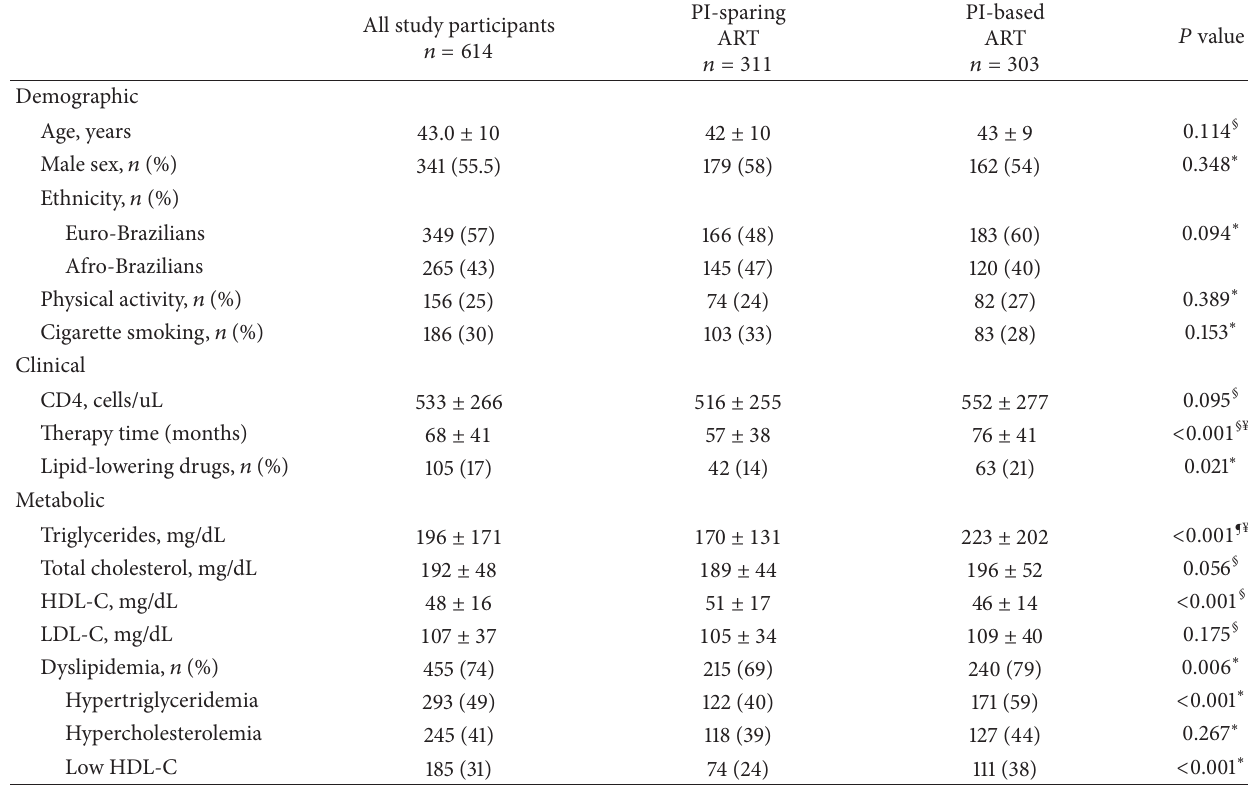
Table 2: Characteristics of the study